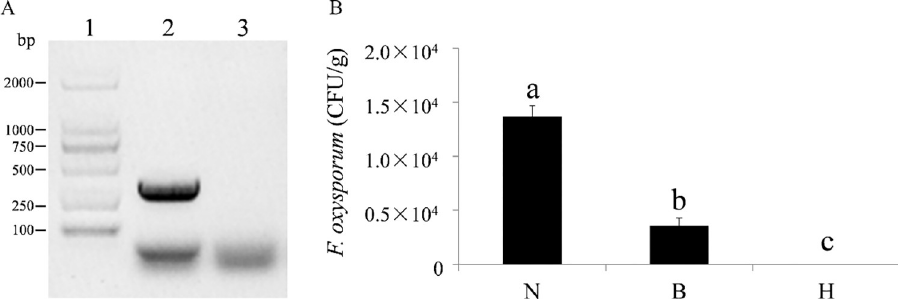
DL2000 DNA marker (Takara, Japan), Lane 2: F . oxysporum , Lane 3: negative control. (B) Distribution of the colony forming unit per one gram (CFU/g) of F . oxysporum in the N (Necrosis), B (Border) and H (Health) zones.